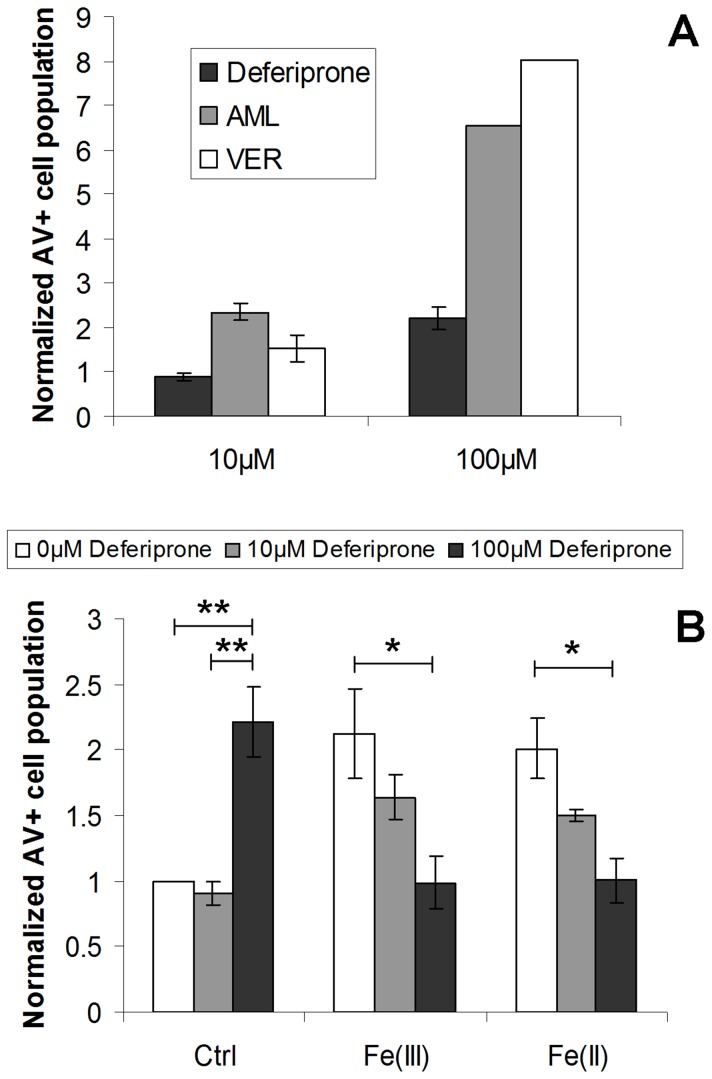
Cellular toxicity of LTCC blockers and the comparison with deferiprone.(A) Apoptotic effects of 10 or 100 µM AML, VER and deferiprone on HL-1 cells for 72 hr were assessed by annexin V/PI flow cytometry assay. (B) HL-1 cells were challenged with 300 µM Fe(III) or Fe(II), followed by treatments of 10 or 100 µM deferiprone 20 min after iron loading. Apoptosis was determined after 72 hr incubation by annexin V/PI assay. Data were shown as total annexin V positive cell portion with normalization to respective negative controls. * p<0.05; ** p<0.01. The results represented as mean ± SEM of three independent experiments, except 100 µM AML and VER (n = 1).